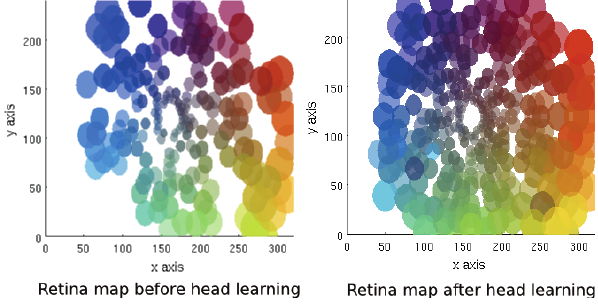
Figure 8. Retina eye map from learning from three targets for 10 minutes with just the eye, then a further 50 minutes with the head moving.